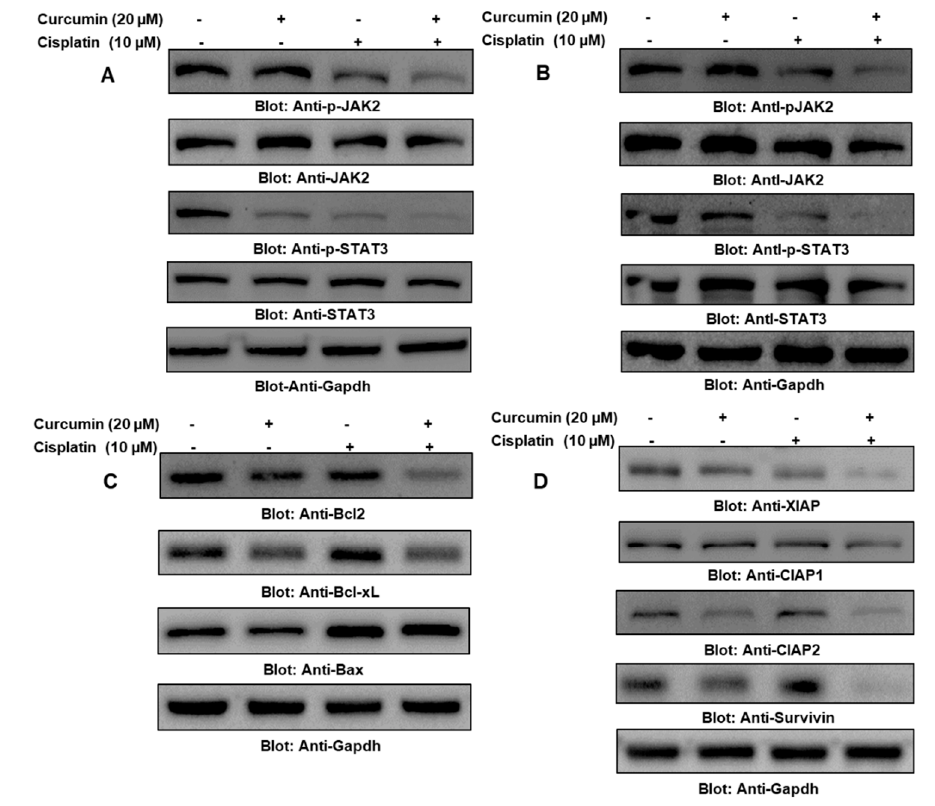
Figure 5. Curcumin and cisplatin synergistically enhanced the inhibition of JAK / STAT3 and Inbibitor of apoptosis proteins (IAPs) and also modulated apoptotic regulators. ( A , B ) The cotreatment of curcumin and cisplatin enhanced the downregulation of JAK / STAT3 in BCPAP and TPC-1 cells. PTC cell lines were treated with 0 µ M or 20 µ M of curcumin and 10 µ M of cisplatin alone and in combination, and after cell lysis, equal amounts of proteins were separated by SDS-PAGE, transferred to a PVDF membrane, and immunoblotted with antibodies of p-STAT3, STAT3, p-JAK2, JAK2, and Gapdh ( C ) Curcumin and cisplatin modulated the expression of antiapoptotic and proapoptotic proteins in PTC cells. BCPAP cells were treated with 0 µ M and 20 µ M of curcumin and 10 µ M of cisplatin alone and in combination, and after cell lysis, equal amounts of proteins were separated by SDS-PAGE, transferred to a PVDF membrane, and immunoblotted with antibodies of Bcl2, Bclxl, Bax, and Gapdh. ( D ) Curcumin and cisplatin synergistically downregulated IAP expression in PTC cells. BCPAP cells were treated with 0 µ M or 20 µ M of curcumin and 10 µ M of cisplatin alone and in combination, and after cell lysis, equal amounts of proteins were separated by SDS-PAGE, transferred to a PVDF membrane, and immunoblotted with antibodies of XIAP, CIAP1, CIAP2, Survivin, and